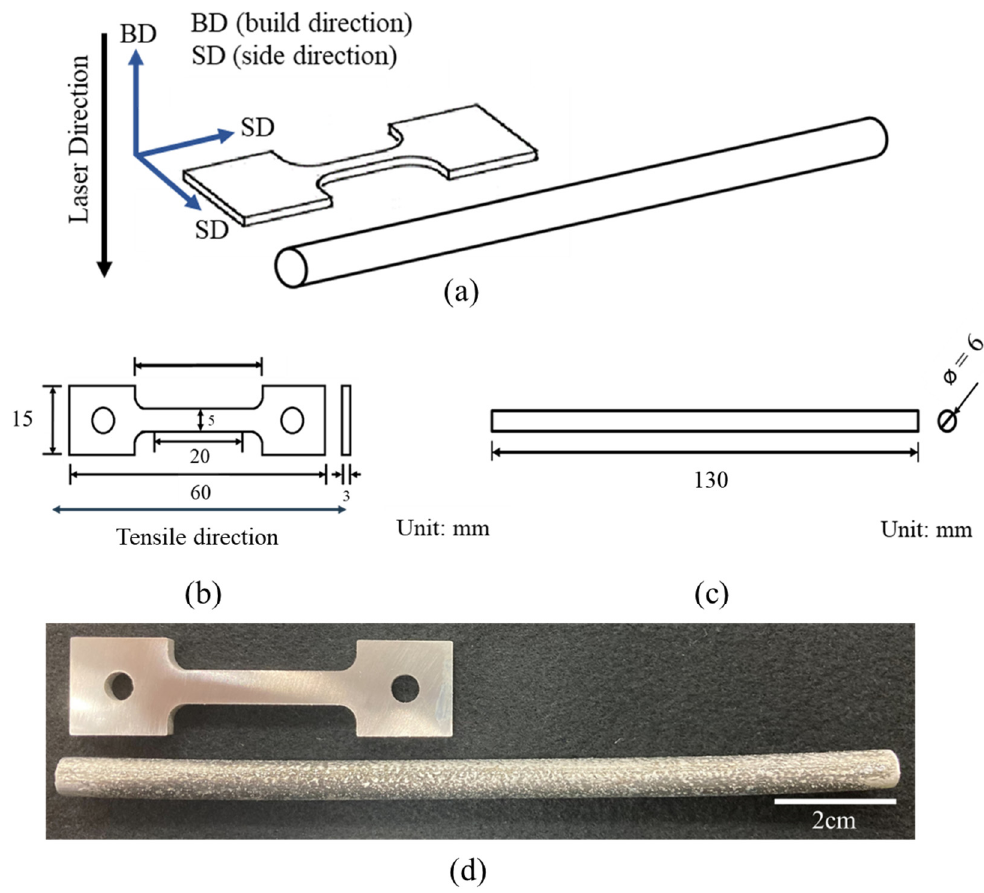
Figure 2. Schematic of the specimen of the Al-Ni-Cu alloy: ( a ) manufacturing direction, ( b ) tensile specimen, ( c ) fatigue specimen, and ( d ) macroscopic morphology photographs.